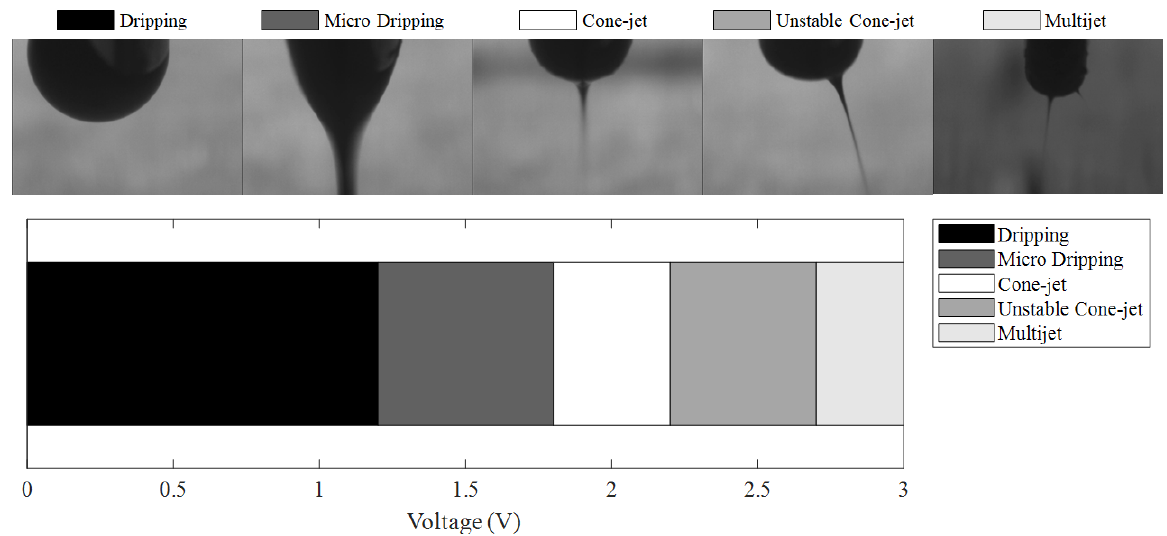
Figure 3. Diagram of meniscus stability for voltage conditions and meniscus shapes.